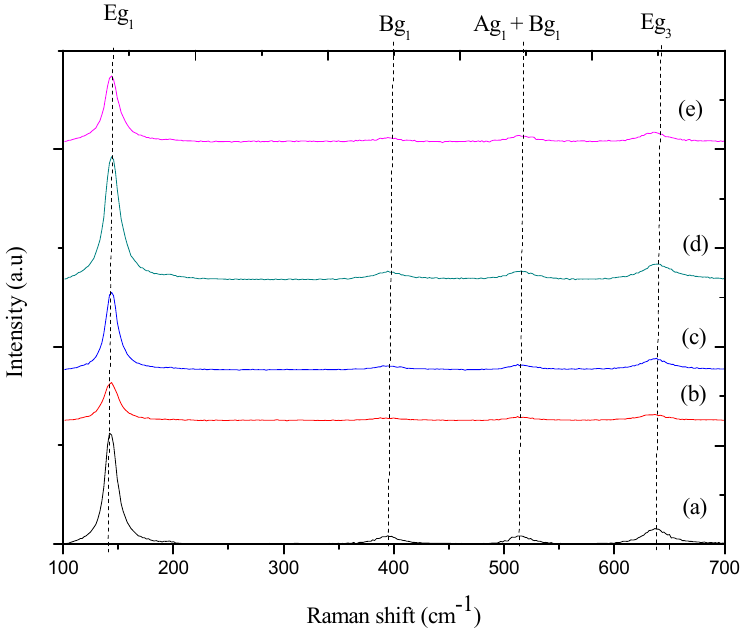
Figure 6. Raman spectra showing peaks for samples ( a ) Cu ‐ 00; ( b ) Cu ‐ 01; ( c ) Cu ‐ 02; ( d ) Cu ‐ 03; and ( e ) Cu ‐ 04.